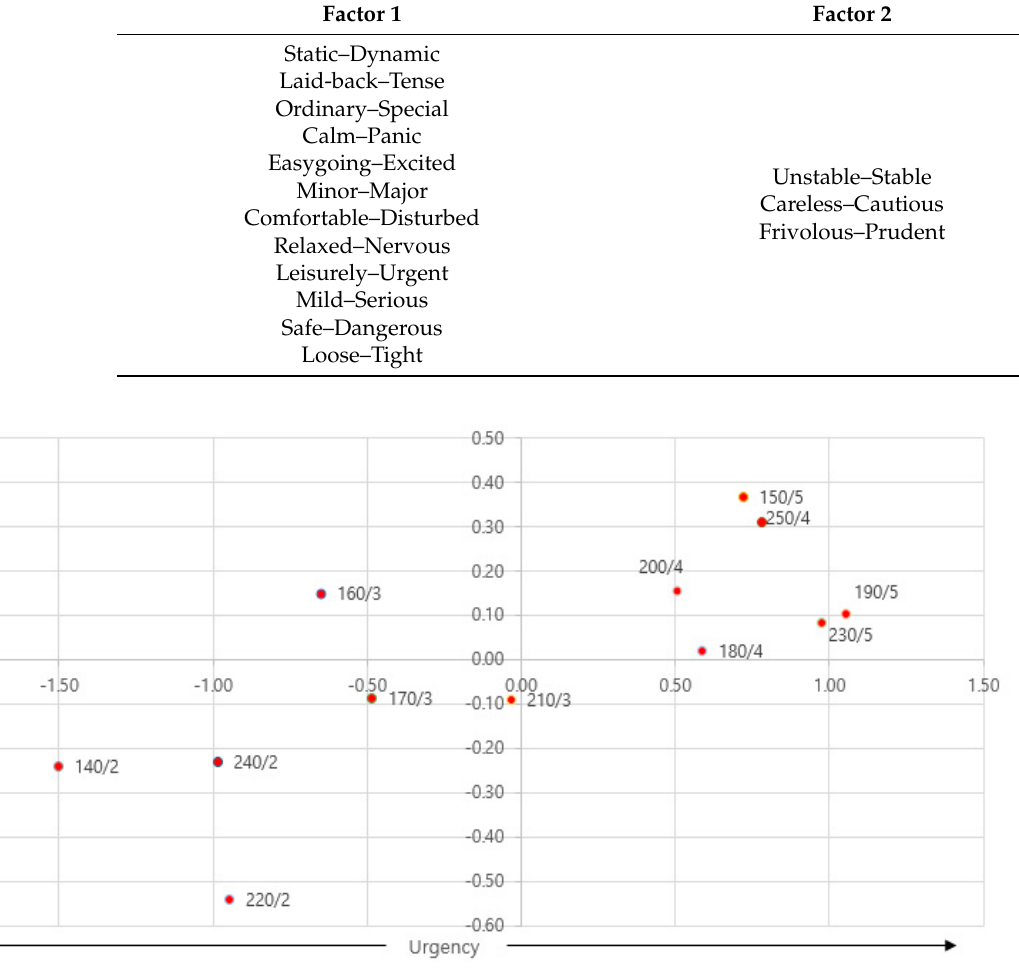
Figure 6. Emotional map of “urgency” and “dangerousness”.